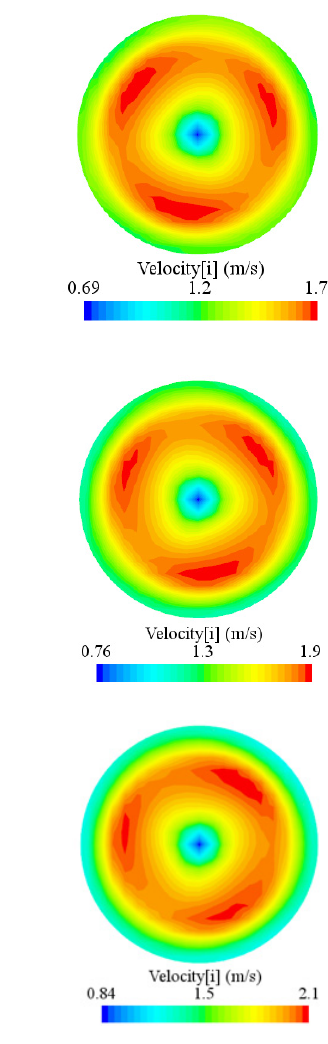
19 of 26 Figure 27. Self-propulsion results of the hybrid-driven AUG with the single propeller. As can be seen, with the increase in the rotation rate, the thrust of the propeller in- creased signi fi cantly at the given speed of 1.4 m/s, while the resistance of the hybrid- driven AUG increased relatively slowly. It was estimated from the intersection point of the curves in Figure 27 that the propeller rotation speed for self-navigation was 800 rpm when the thrust and the resistance were close to equilibrium and the AUG reached a stable speed. Table 3 shows that when the propeller was simulated at 800 rpm, the propeller thrust was 10.98 N and the resistance of the hybrid-driven AUG was 11.044 N, with a di ff erence of 0.6%. This was considered that the hybrid-driven AUG had reached the self- propulsion state. Table 3. Calculation results of the self-propulsion state for the hybrid-driven AUG with the single propeller. V (m/s)